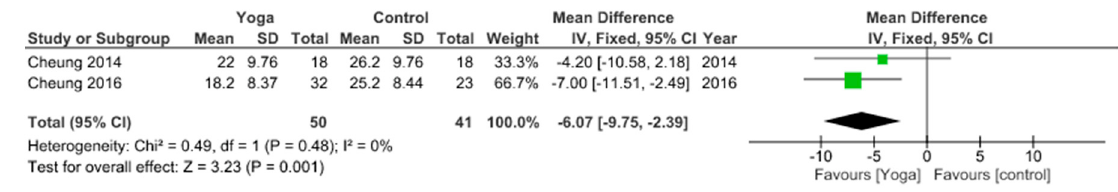
Figure 10. Function: Tai Chi versus Control.